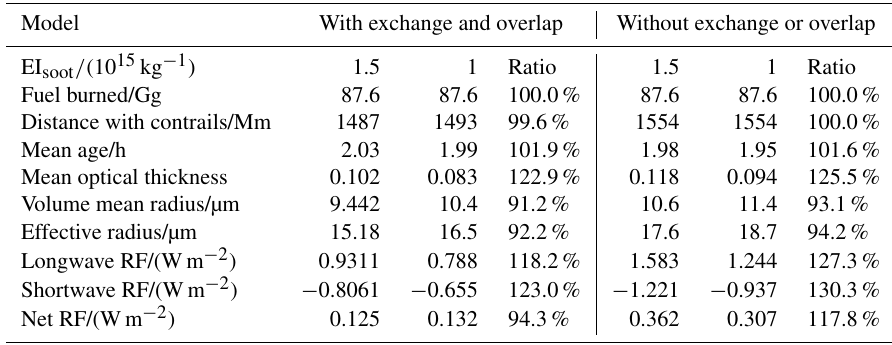
Table 6. Sensitivity to soot emission index in two CoCiP model versions (July